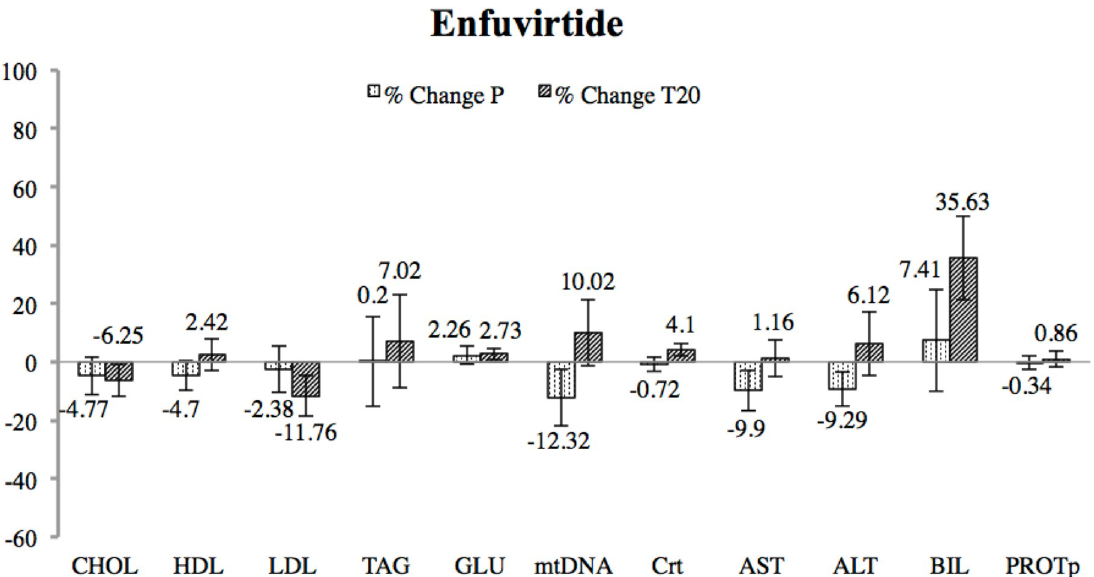
Fig 2. Percentage of change between final and baseline measurements for enfuvirtide (T20) and placebo interventions. Significance was assessed through a Wilcoxon test. Variation is represented with error bars through the SEM value. No significant change was detected after T20